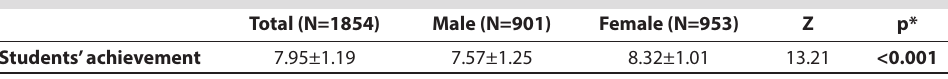
TABLE 2 Academic Achievement Points According to